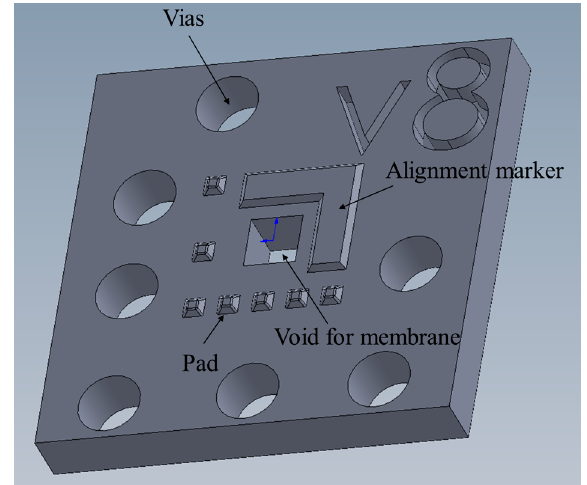
Figure 1. 3D sketch of the package housing printed with the multi-jet polymer